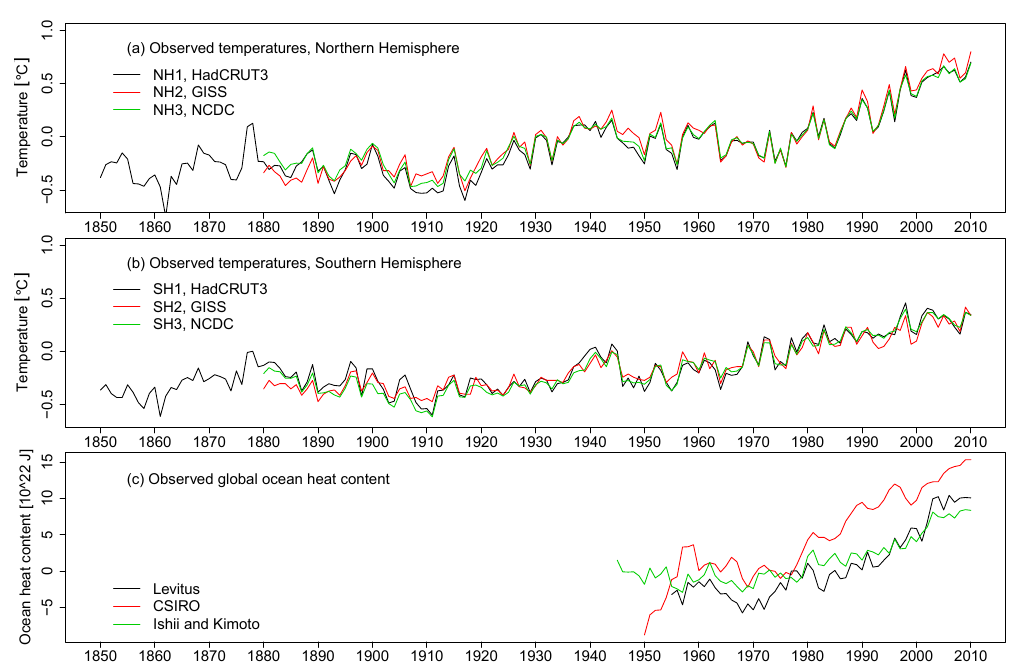
Fig. B1. Annual temperature and ocean heat content data. HadCRUT3, University of East Anglia and the Hadley Centre; GISS, Goddard Institute for Space Studies; NCDC, National Climatic Data Center; CSIRO, Commonwealth Scientific and Industrial Research Organisation.